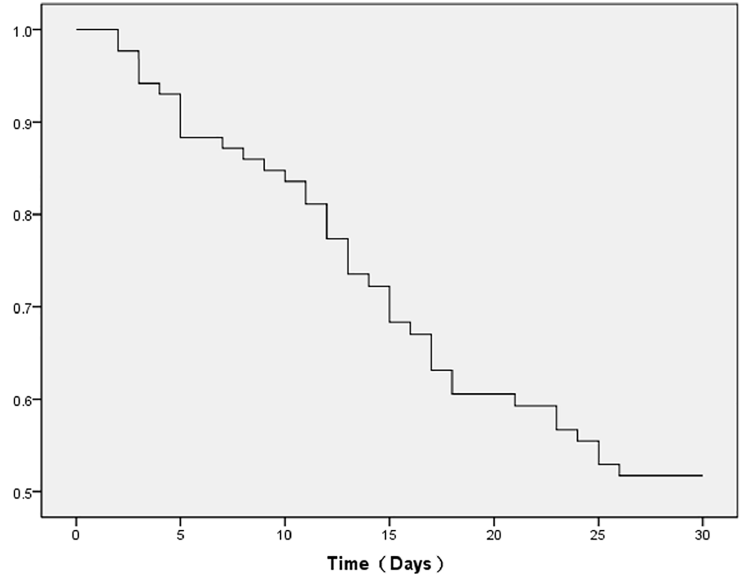
Fig 3. Survival time of 81 paraquat-poisoned patients (plasma paraquat levels: 1,000–5,000 ng/mL).